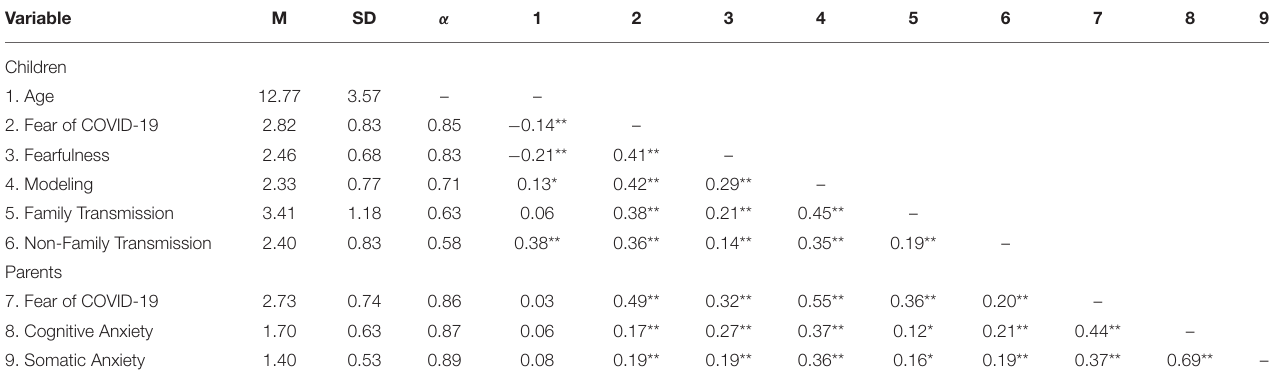
TABLE 1 | Descriptive statistics, reliability coefficients, and intercorrelations for study variables. Variable